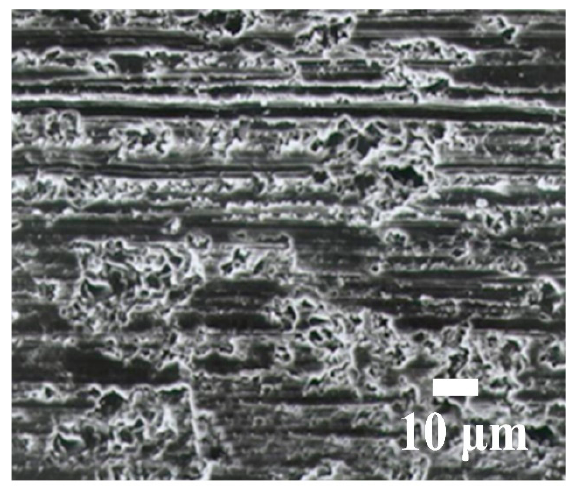
Figure 13. Machined surface for WSM using a fixed abrasive (diamond).